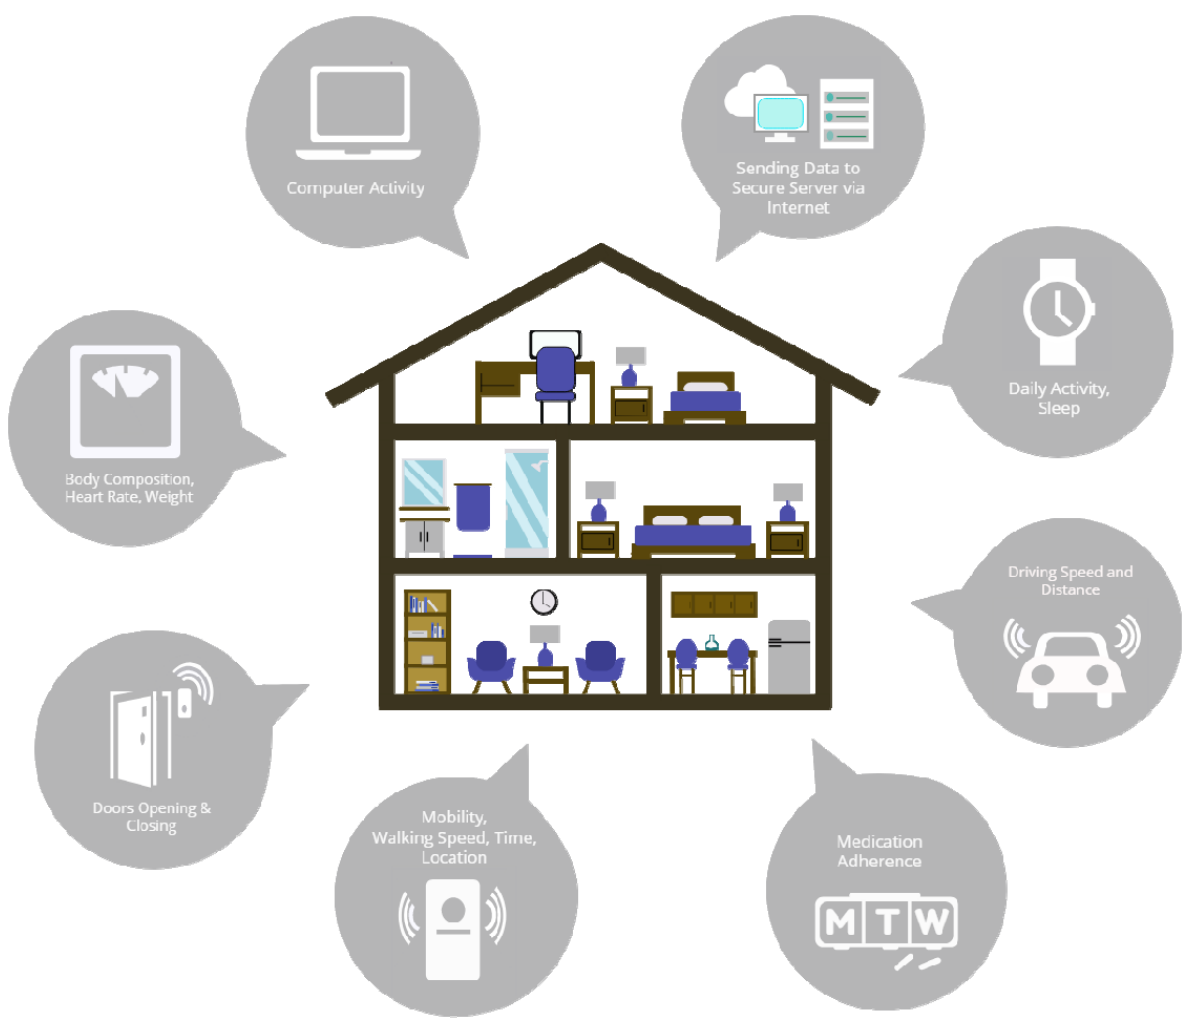
Figure 1. Illustration of the full suite of integrated assessment platforms built into participants’ (Life Lab), through The ORegon Center for Aging and TECHnology (ORCATECH) supported by the homes (Life Lab), through The ORegon Center for Aging and TECHnology (ORCATECH) sup- NIH National Institute of Aging as a designated Roybal ported by the NIH National Institute of Aging as a designated Roybal Center.